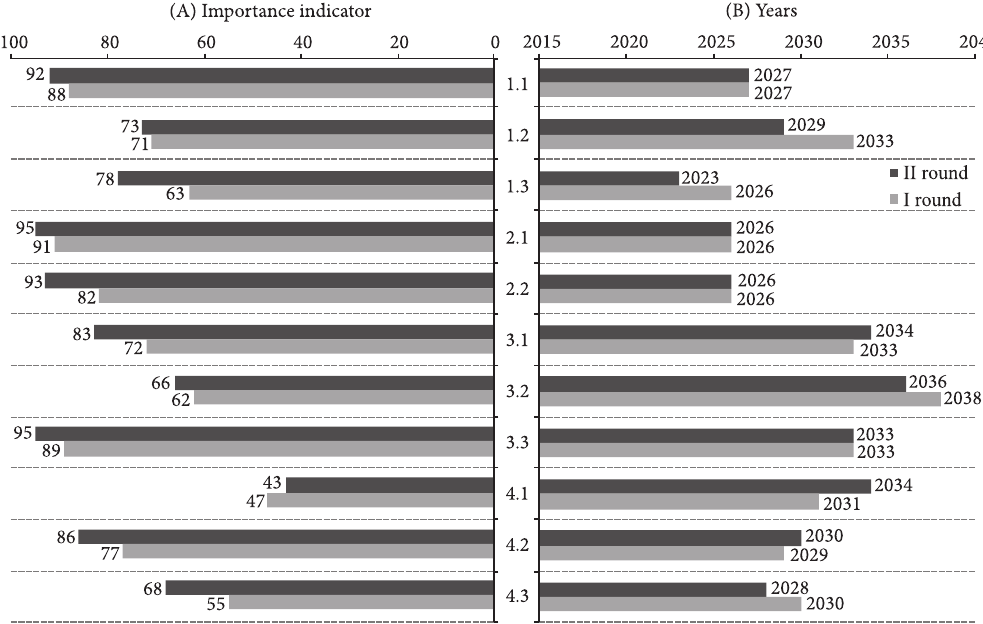
Fig. 2. Levels of significance index for examined theses (A) and the thesis medians realisation time (B) in the two rounds of Delphi